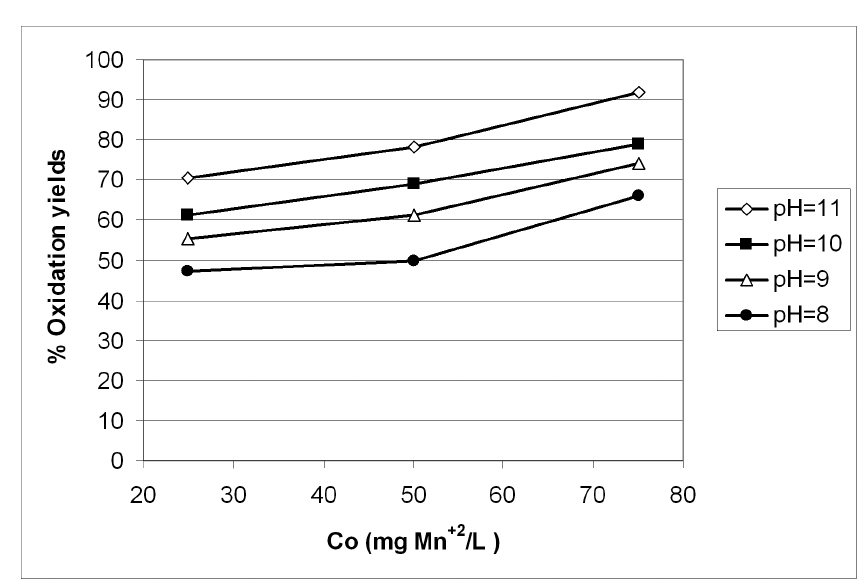
Fig. 1 Oxidation yields as a function of pH and concentration (20 ◦ C, solution without